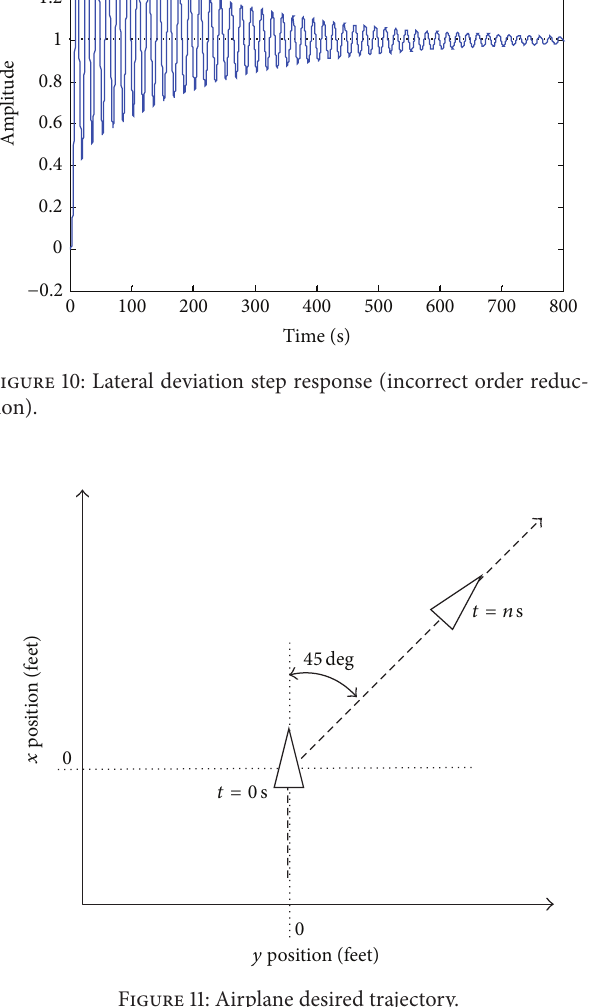
Figure 11: Airplane desired trajectory.